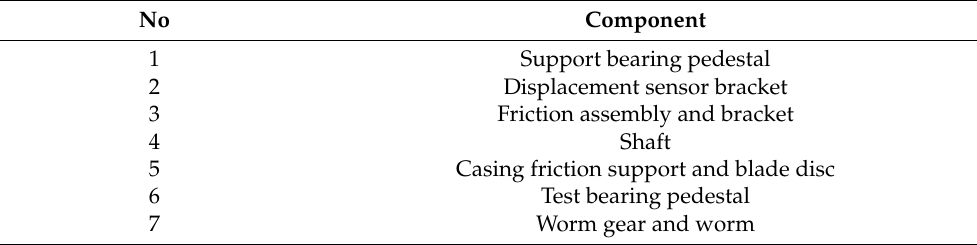
Table 2. The structural components of the single-span rotor shafting.